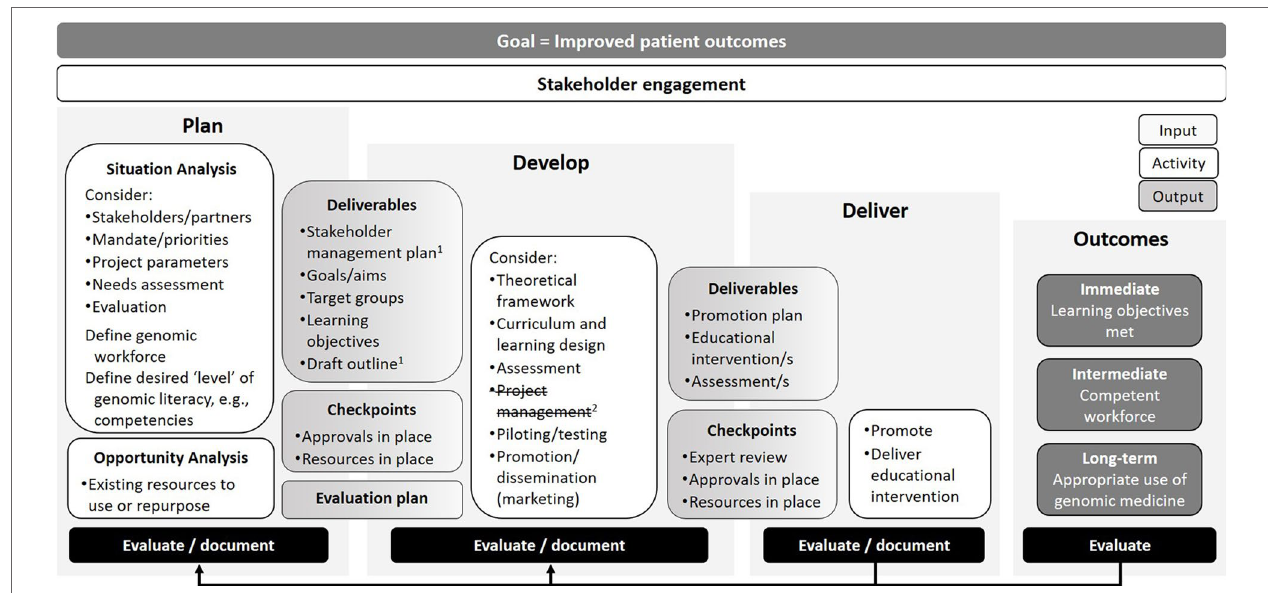
FIGURE 2 | Program logic model for genomic education interventions. 1 After testing the model in four contexts a stakeholder management plan was added as a Planning stage deliverable. 2 Testing also clarified that Project management aspects can span all stages so this component was